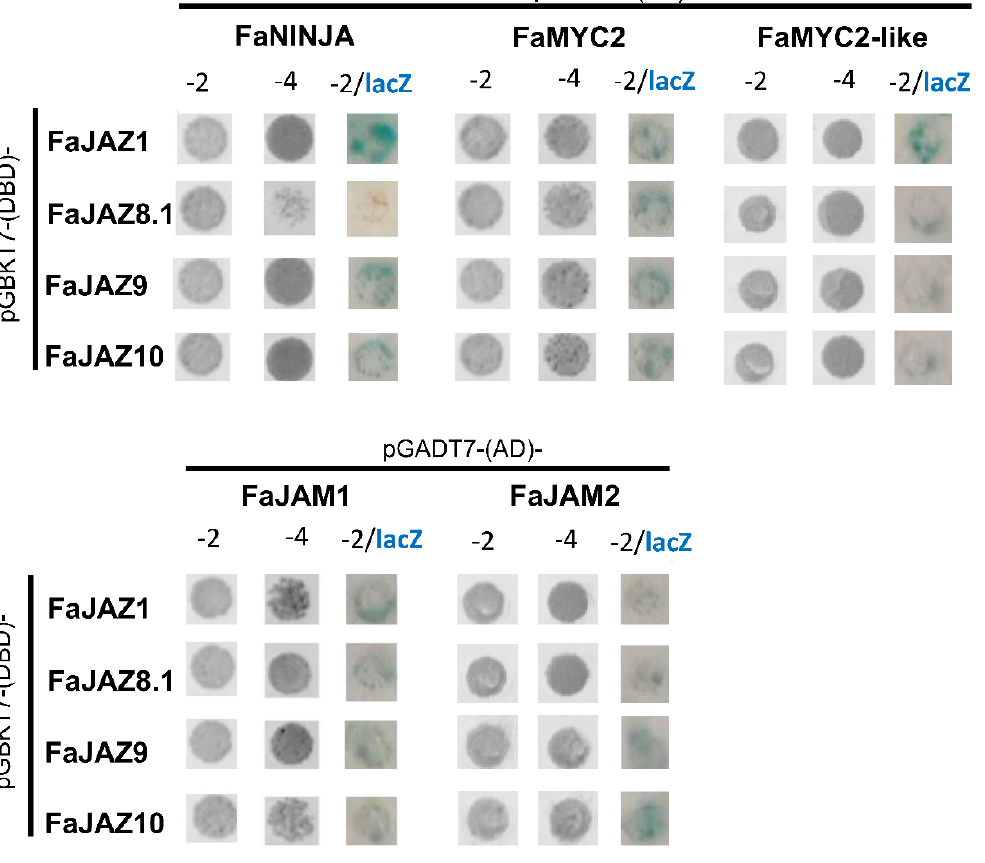
Figure 1. Protein–protein interactions of Fragaria × ananassa JASMONATE ZIM-DOMAIN (FaJAZs) repressors with components of the jasmonate (JA)-signaling pathway. FaJAZ1, FaJAZ8.1, FaJAZ9, and FaJAZ10 were cloned into pGBKT7-(DBD)-Gateway vector. F. × ananassa NOVEL INTERACTOR OF